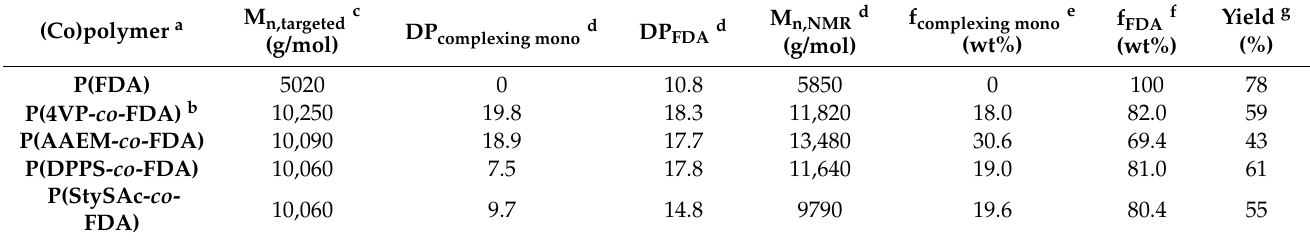
Table 1. Synthesis by RAFT polymerization of P(FDA) and gradient complexing